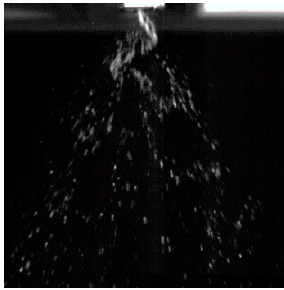
Figure 6. Instantaneous high-speed photo of fluidic atomizer spray. Photo indicates flapping motion of the fluid generated by unsteady oscillation induced by the fluidic inner geometry.